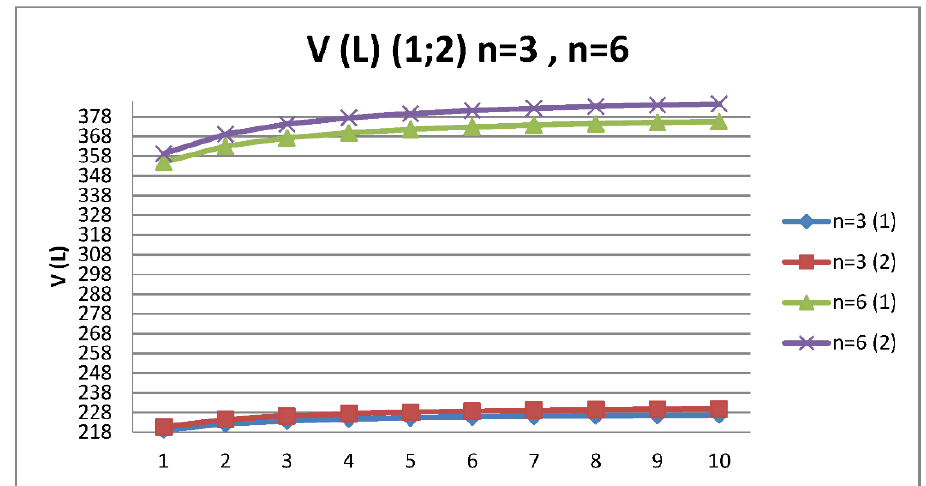
Figure 8. Dependence of the company value, V , on leverage level L in the cases of payments of tax on profit at the end of the year (1) and in the beginning of the year (2) for three-year and six-year companies.